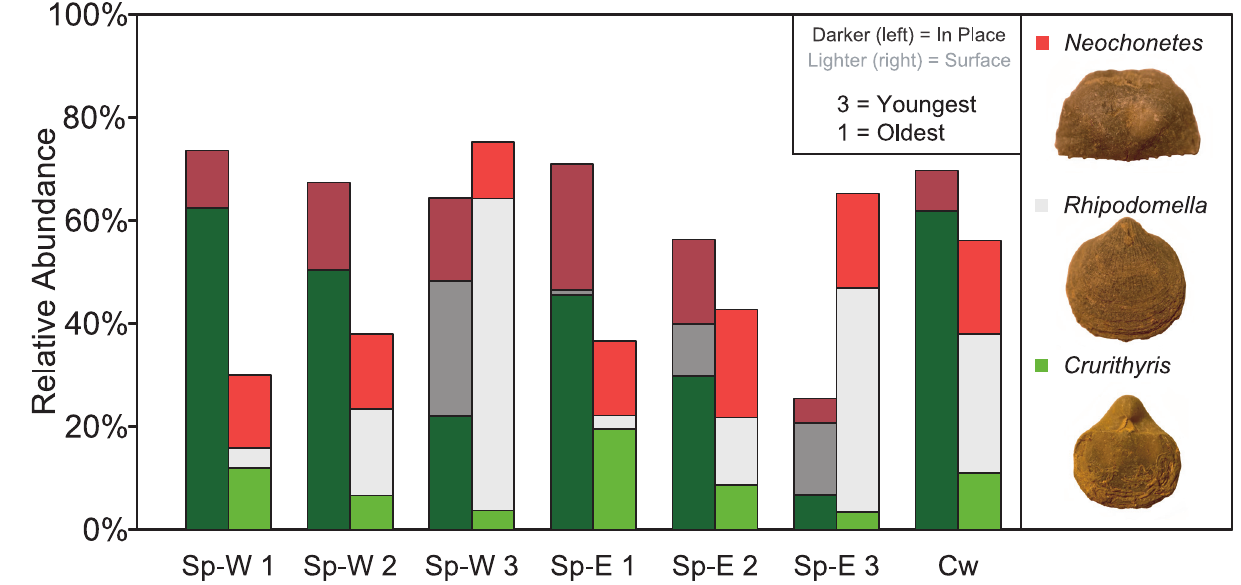
Fig 6. Relative abundance of select brachiopod genera. Relative abundance of the three most abundant genera (all brachiopods) across all samples compared between the in-place and surface samples. SpE = Spillway East outcrop, SpW = Spillway West outcrop, CW = Causeway Road outcrop. The lower the number, the lower stratigraphic